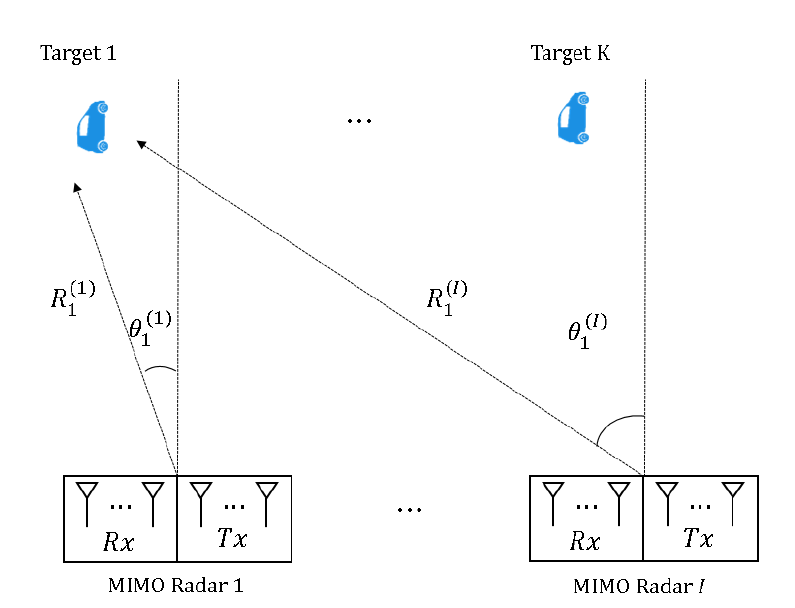
Figure 1. Distributed FMCW MIMO radar and the multiple target